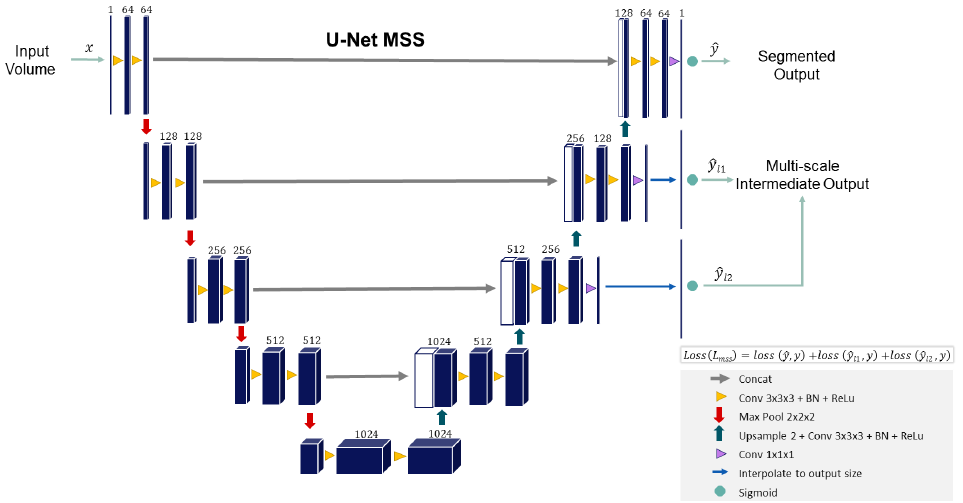
Figure 1. Proposed network backbone: Modified U-Net Multi-scale Supervision (Modified U-Net MSS).